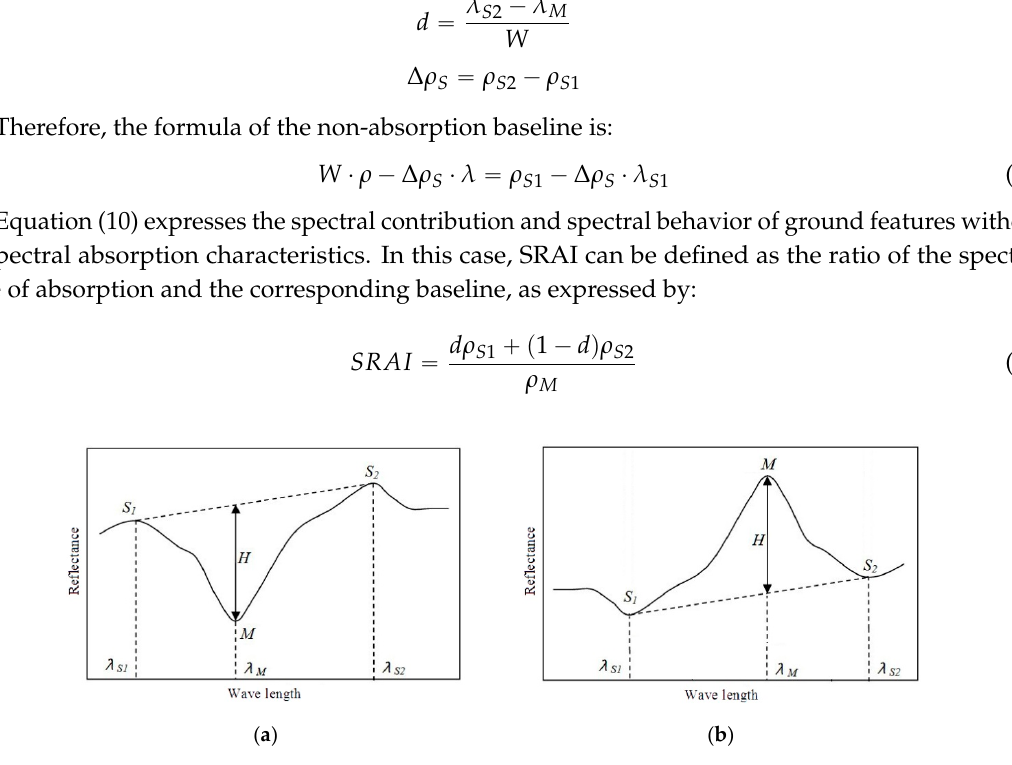
Figure 1. Illustrations of SRAI ( a ) absorption and ( b ) reflection.